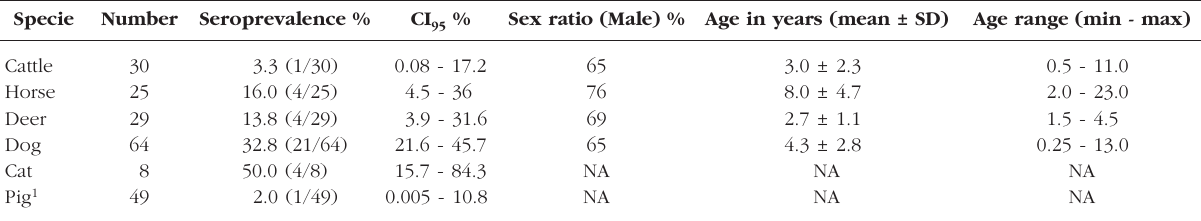
Table I. – Distribution of the study population according to age and sex and prevalence of Toxoplasma gondii